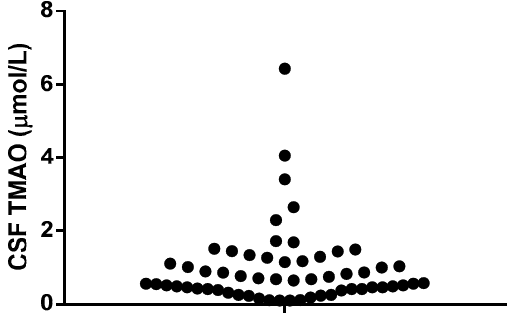
Figure 1. Trimethylamine- N -oxide (TMAO) concentrations in human cerebrospinal fluid (CSF). TMAO was quantified as described in the method section.